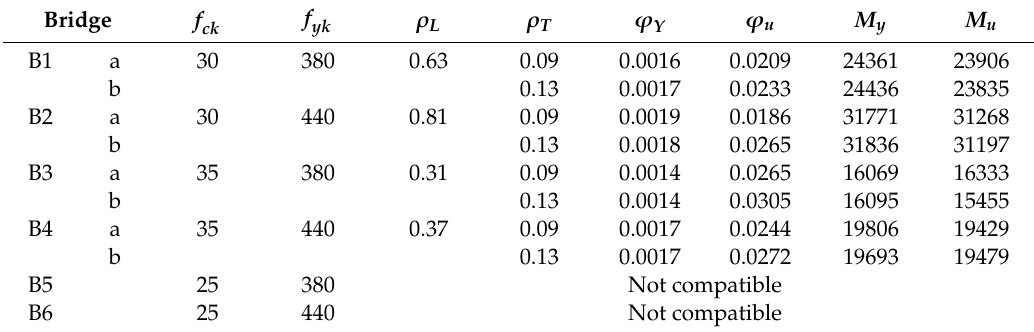
Table 3. Design data, reinforcement ratio of the generated index bridges and results of the moment curvature analysis of the pier